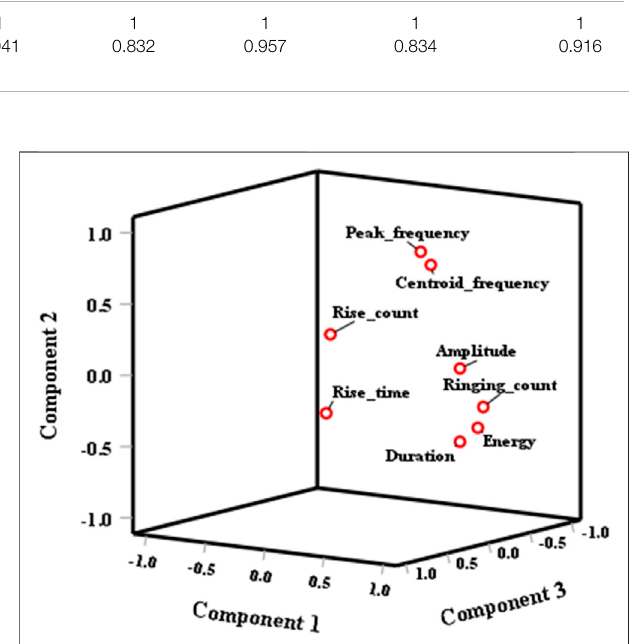
FIGURE 7 | Factor rotation space